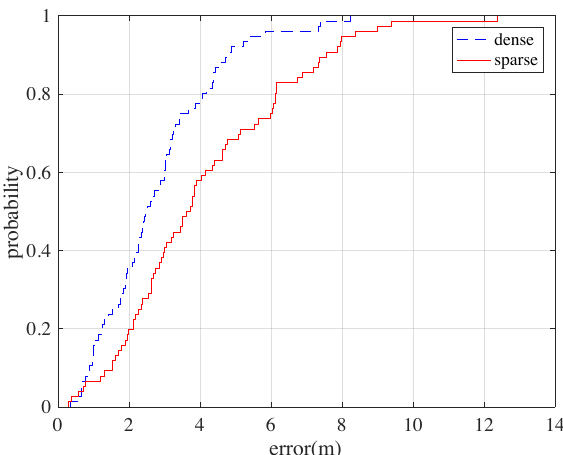
Figure 11. The CDF of positioning errors using the estimated RFM.